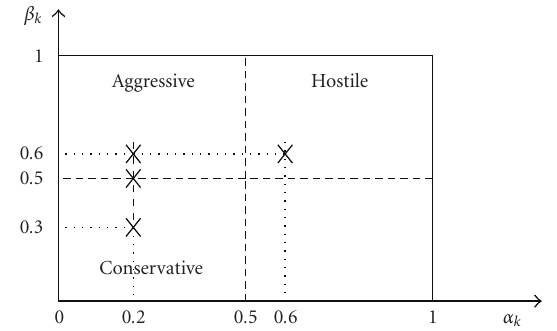
Figure 3: Schema of the CR classes plane. Case studies of Figure 5 are indicated with a